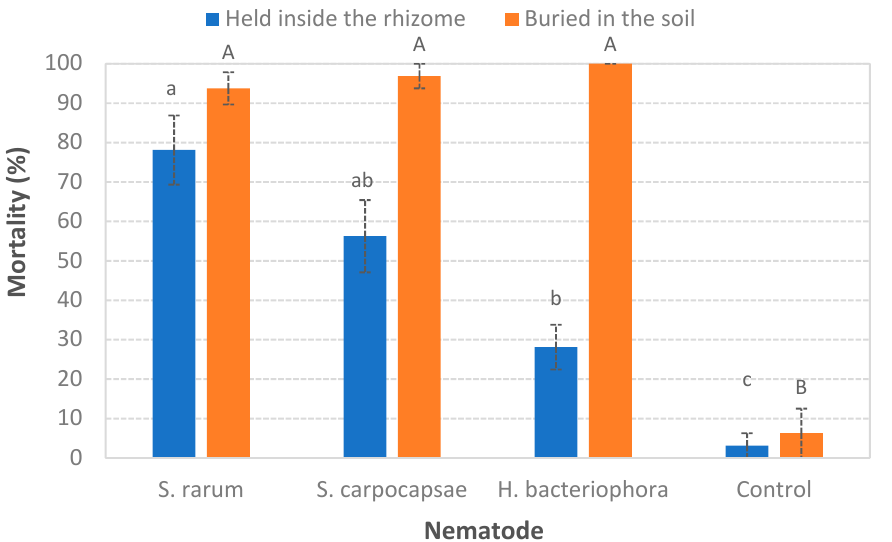
Figure 4. Mortality of Sphenophorus levis larvae caused by entomopathogenic nematodes seven days after application. Held inside the rhizome = larvae held inside the cane rhizome. Buried in the soil = larvae buried in the soil, outside the cane rhizome. Means followed by different upper- or lower-case letters differ significantly within categories according to Tukey’s test ( p < 0.05).